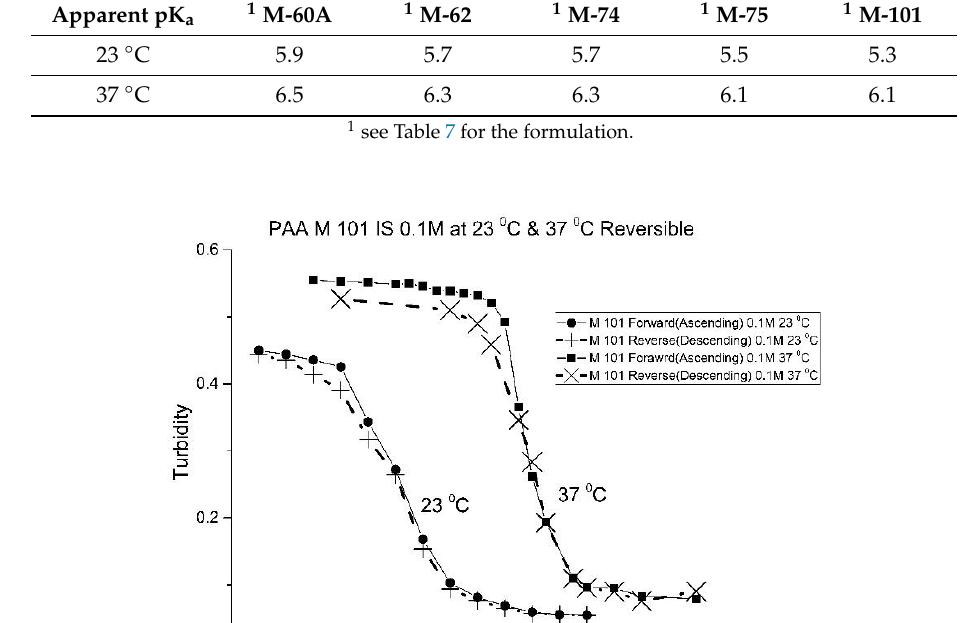
Table 8. pK a Values of N -isopropylacrylamide Copolymers of Propacrylic Acid.